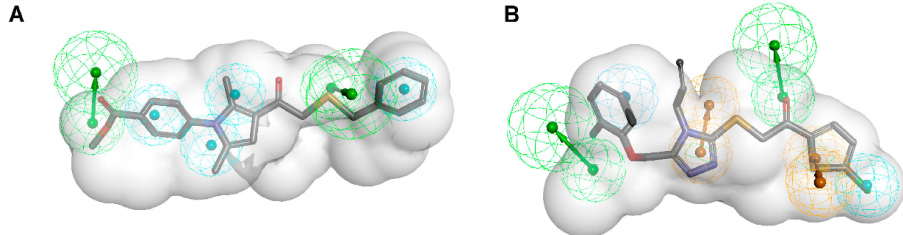
of two HBAs (green) and four H features (blue); ( B ) The non-selective inhibitor 2-2 mapped the nonsteroid-based 17 β -HSD3 model containing two HBAs, two AR (orange), one H and one H-AR feature